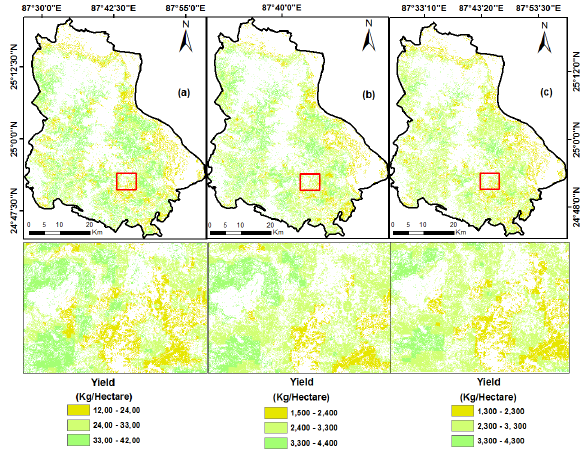
Figure 3. Upscaled paddy yield map into satellite-based footprint scale (a) NDVI model-based, (b) EVI model-based, and (c) Multi-regression model-based.